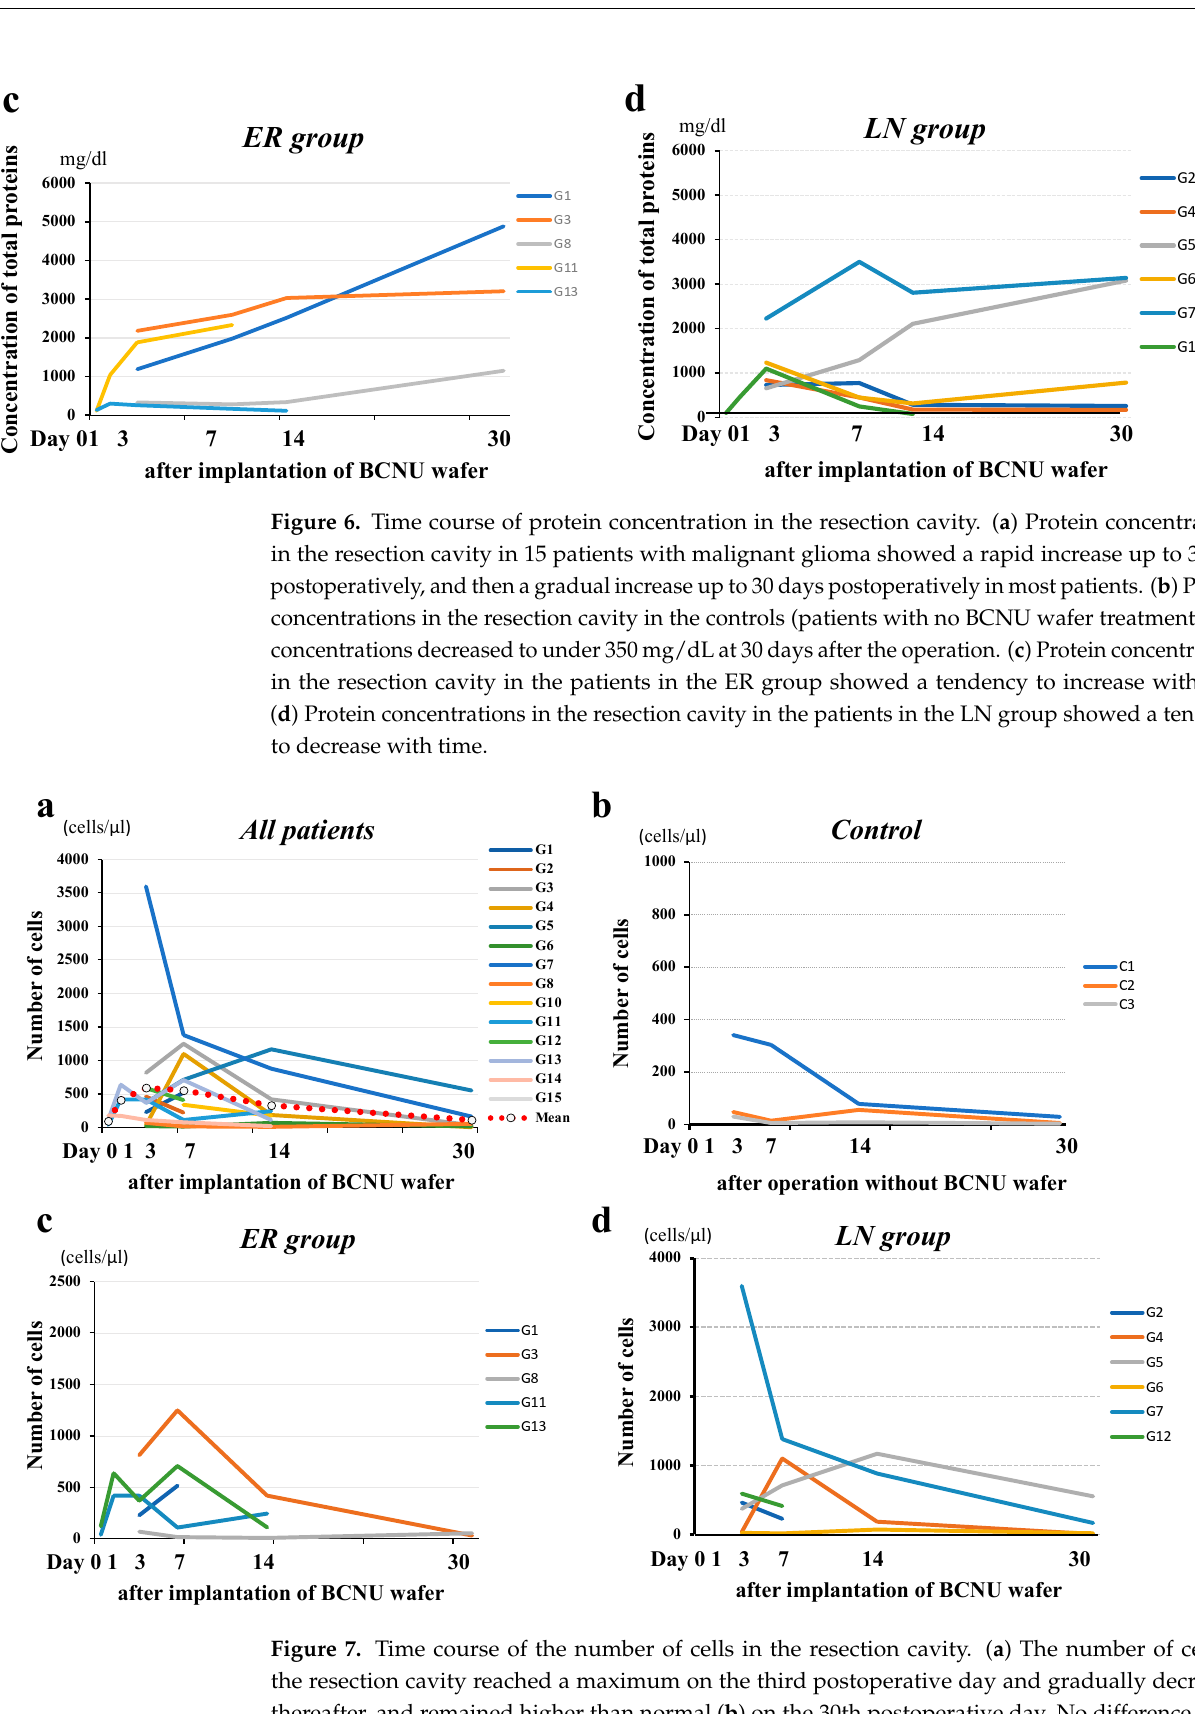
thereafter, and remained higher than normal ( b ) on the 30th postoperative day. No difference in the